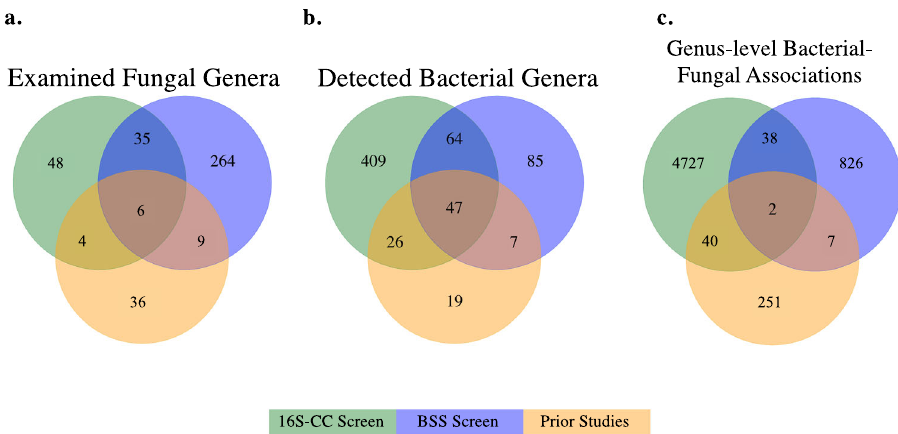
Fig. 1 Fungal taxa, bacterial taxa, and genus-level associations found among the culture collection screen (16S-CC), the bioinformatic screen of fungal genome sequencing projects (BSS) and prior studies. Each diagram displays overlaps in either a examined fungal genera, b bacterial genera detected, or c genus-level bacterial – fungal associations found in the two screens conducted as part of this work and in prior studies.